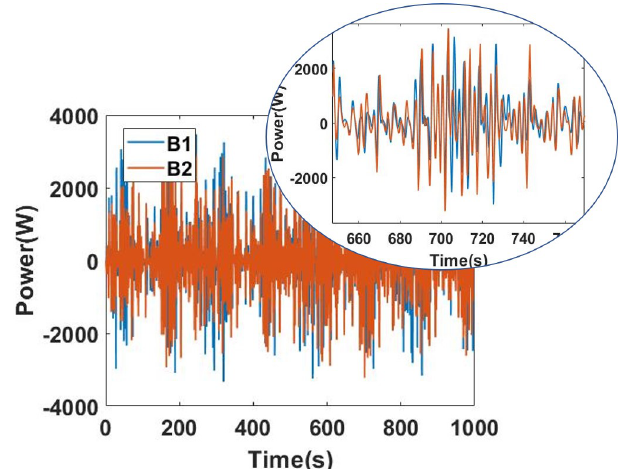
Fig. 3: The comparison between the power extracted by applying the one body approach and two body approach with different mooring stiffness K .